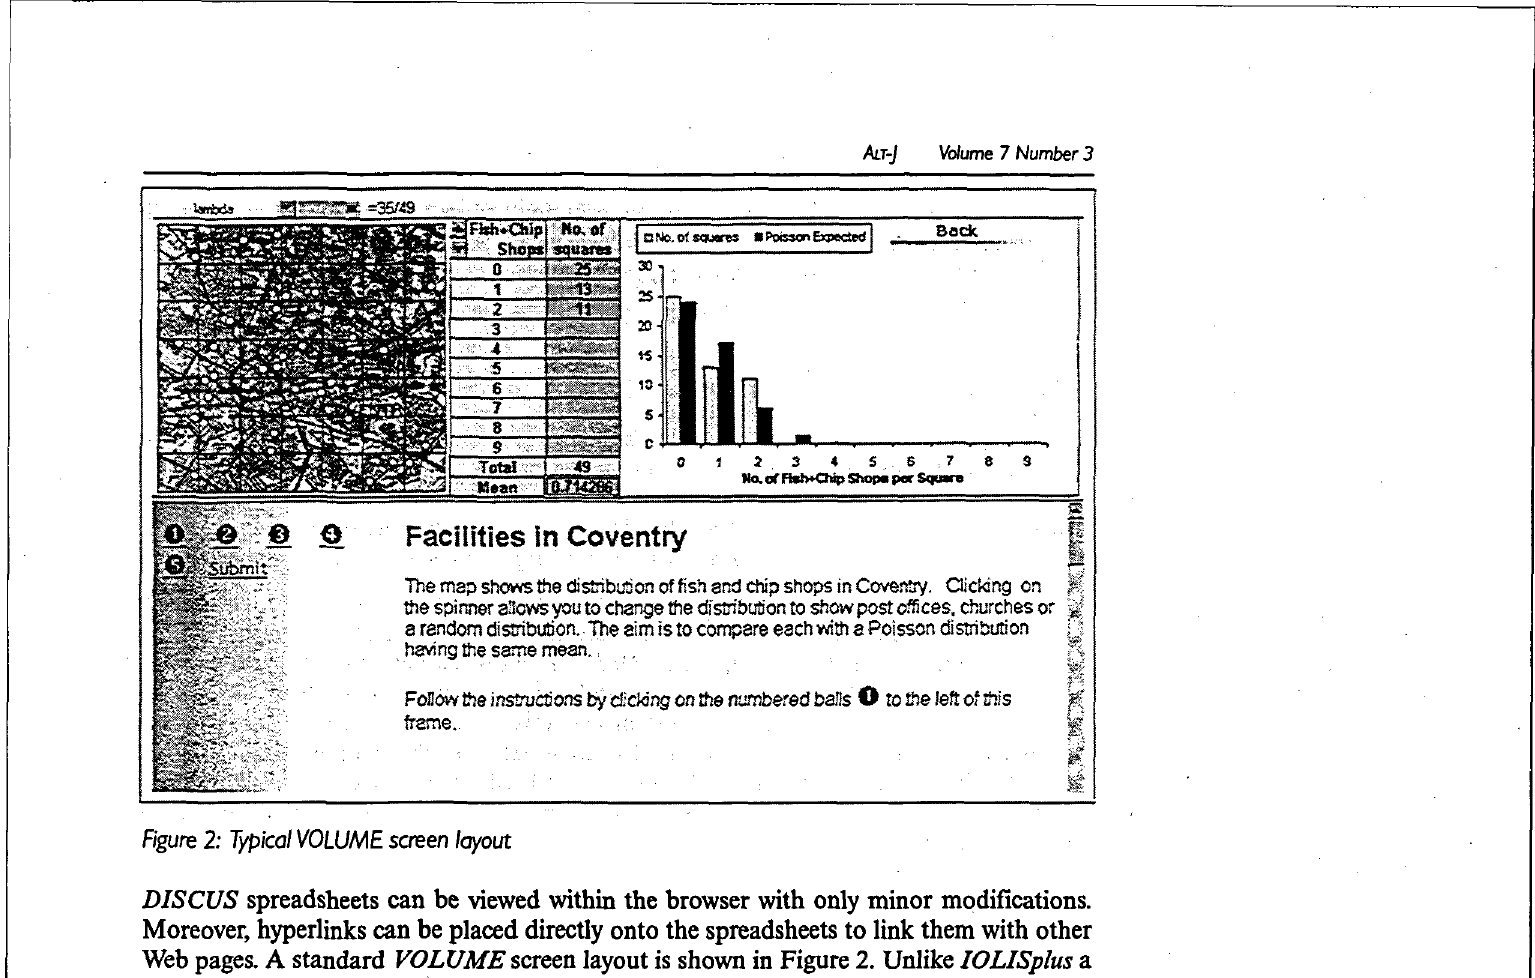
figure 2: 7ypfca/ VOLUME screen layout DISCUS spreadsheets can be viewed within the browser with only minor